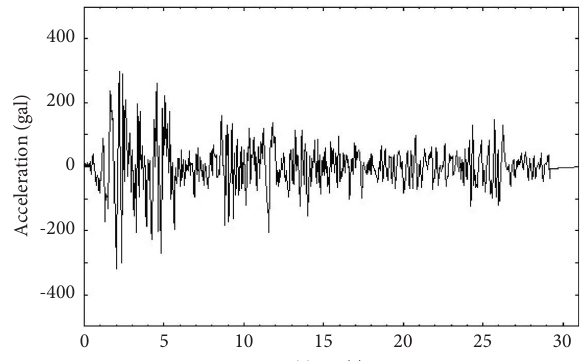
Figure 11: El-Centro wave.